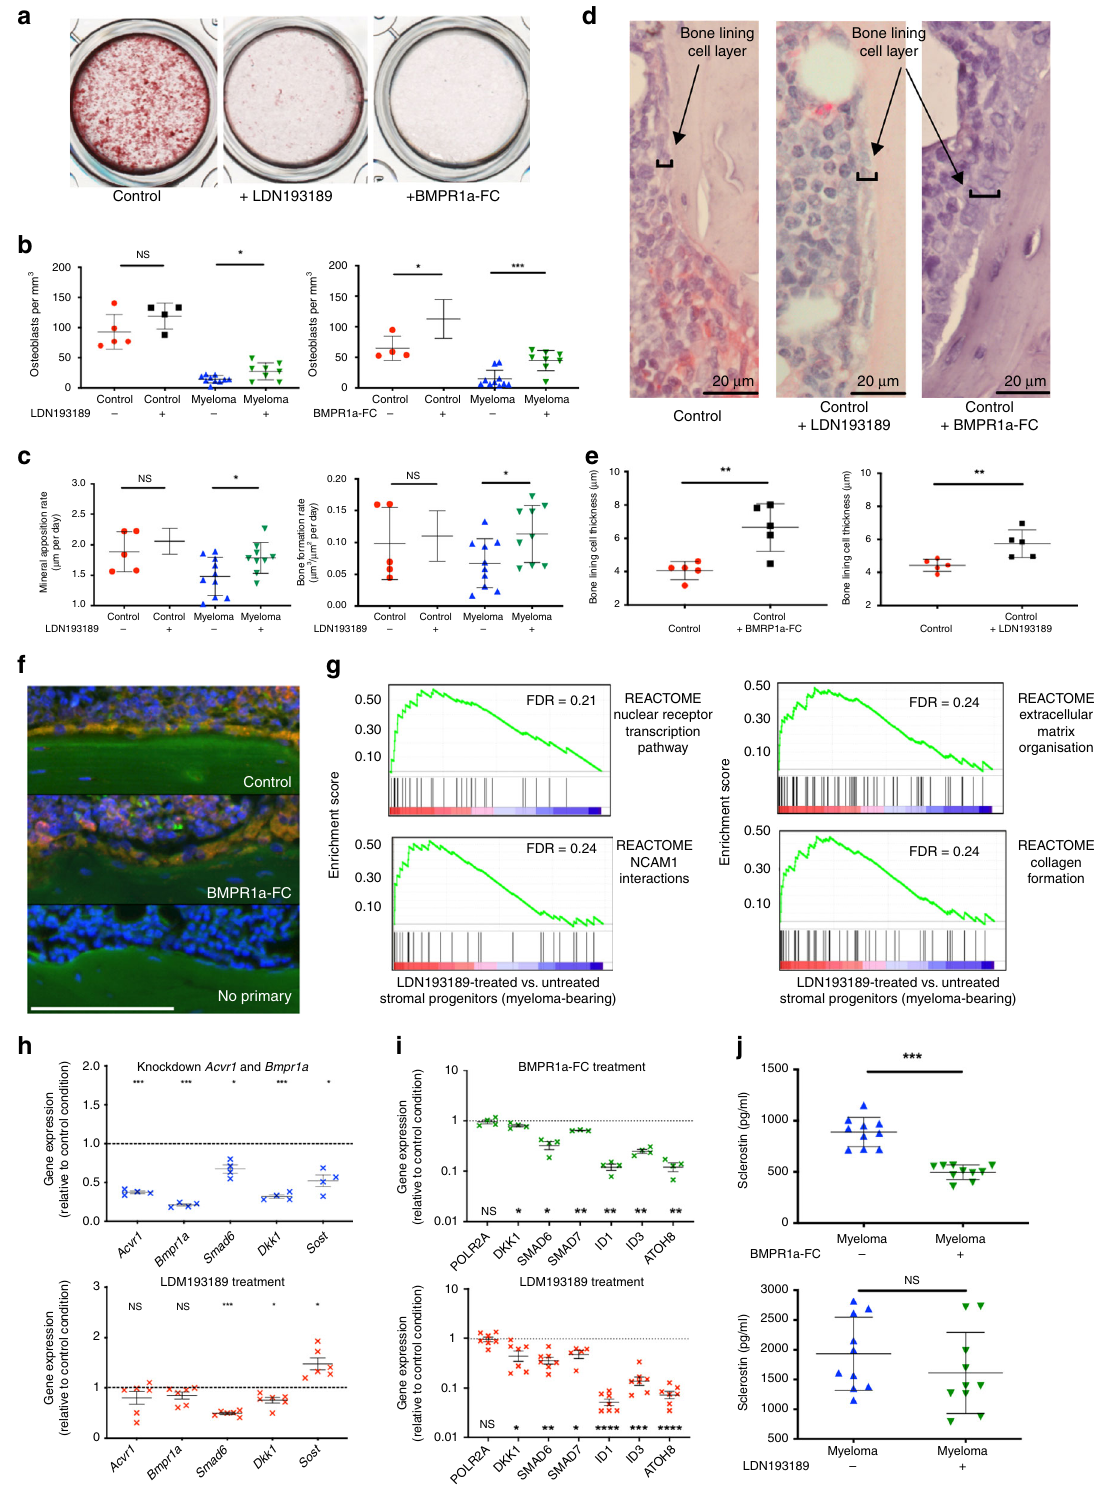
(Fig. 5g, Supplementary Data 2): ‘ Nuclear Receptor Transcrip- tion ’ , in which the most highly enriched gene was Vdr , vitamin D receptor (in top 20 most upregulated genes by LDN in stromal progenitor transcriptome, FDR 0.005); ‘ Collagen formation ’ , ‘ Extracellular matrix organisation ’ and ‘ NCAM1 interactions ’ . The enrichment of the latter three gene sets by LDN in the